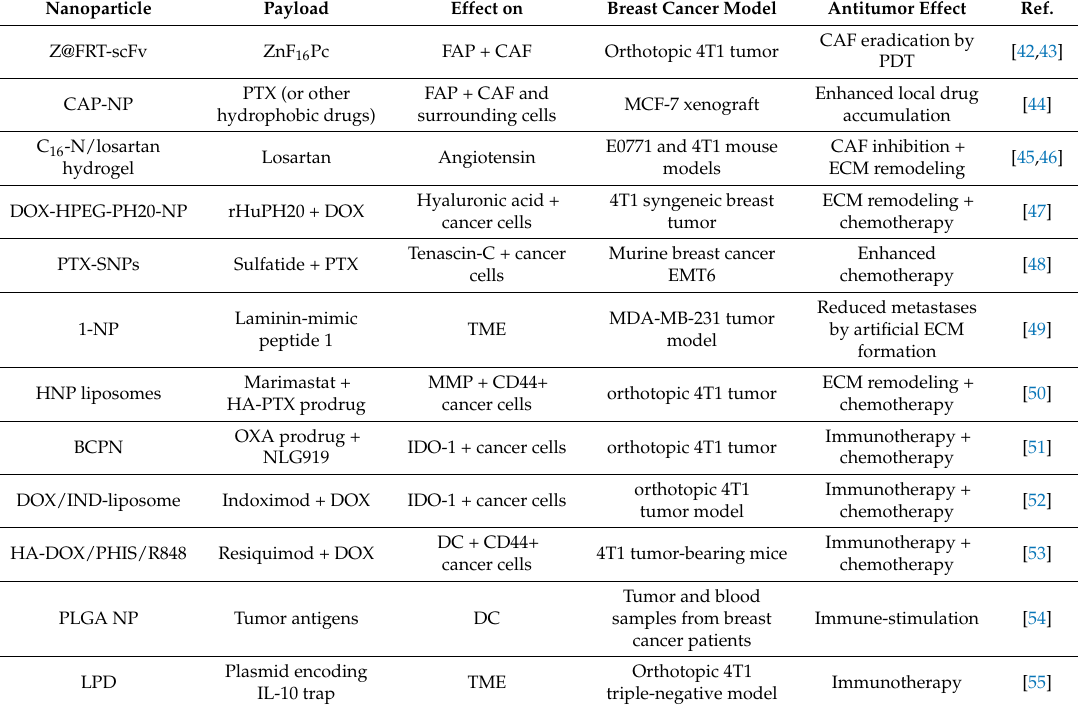
Table 1. Nano-strategies to target CAF and remodel the TME in preclinical models of breast cancer.